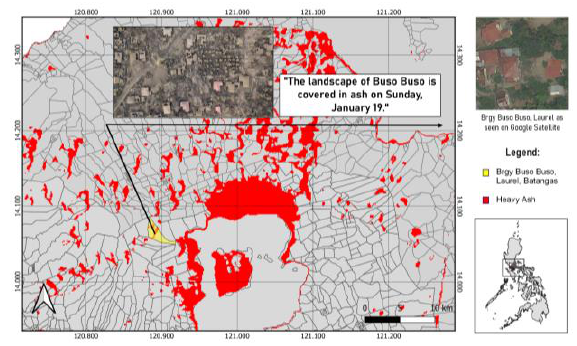
Figure 7. Validating the potential ashfall in Buso Buso,